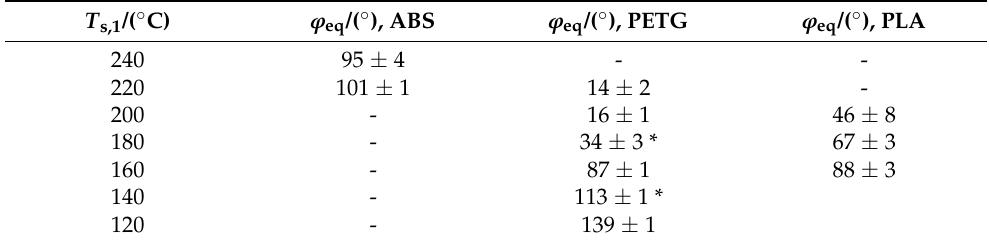
Table 4. Equilibrium contact angles, ϕ eq , for the explored temperature settings in terms of substrate temperature, T s,1 . (*: Equilibrium was not reached in the wetting experiment. Therefore, ϕ eq was estimated as the last observed contact angle (cf. Figure